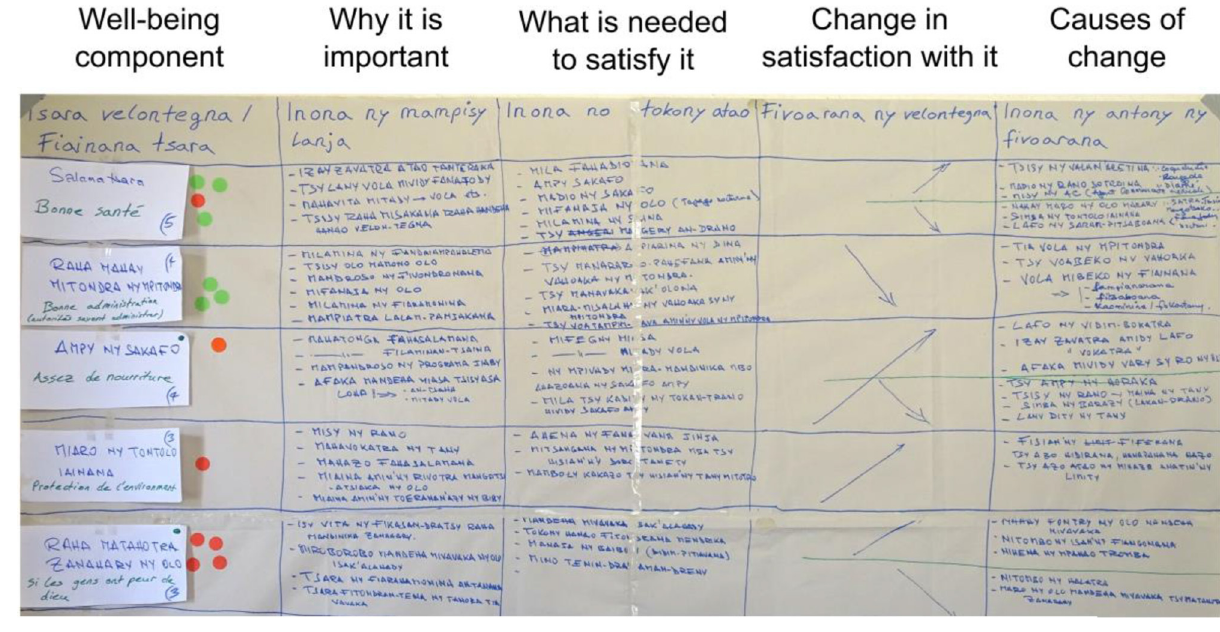
FIGURE 2 | Completed flipchart following a